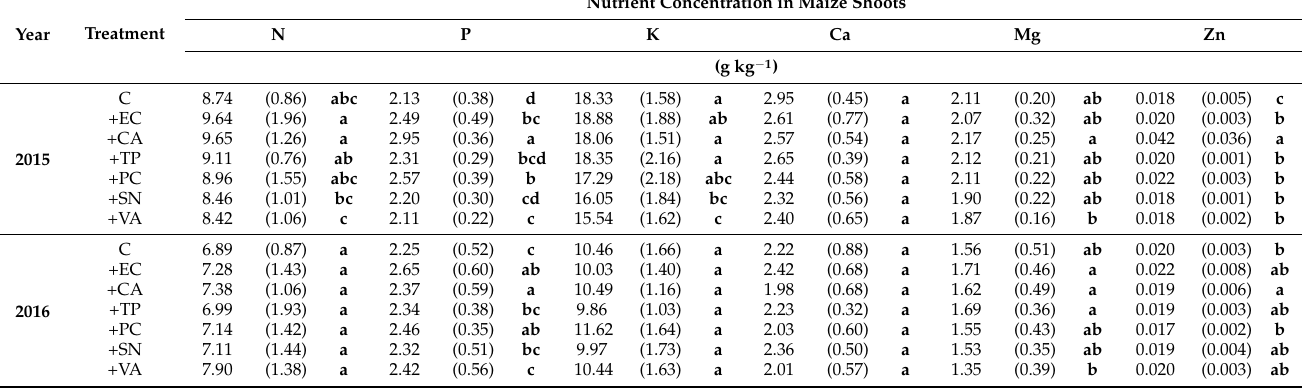
Table 3. Nutrient concentrations (N (g kg − 1 ), P, K, C, Mg, Zn (mg kg − 1 )) of maize shoots in weed-free growth (C) and mixed growth with weeds (+ EC, +CA, +TP, +PC, +SN, +VA) in a pot experiment (6 kg of a P deficient loamy sand per pot) under semi field conditions in 2015 and 2016. Values are expressed as means ± SD. Lower letters indicate significant differences ( p < 0.05, Kruskal-Wallis test, n = 42). (C: control, +EC: maize + Echinochloa crus-galli , +CA: maize + Chenopodium album, +TP: maize + Tripleurospermum perforatum , +PC: maize + Polygonum convolvulus , +SN: maize + Solanum nigrum , +VA: maize + Viola arvensis ).